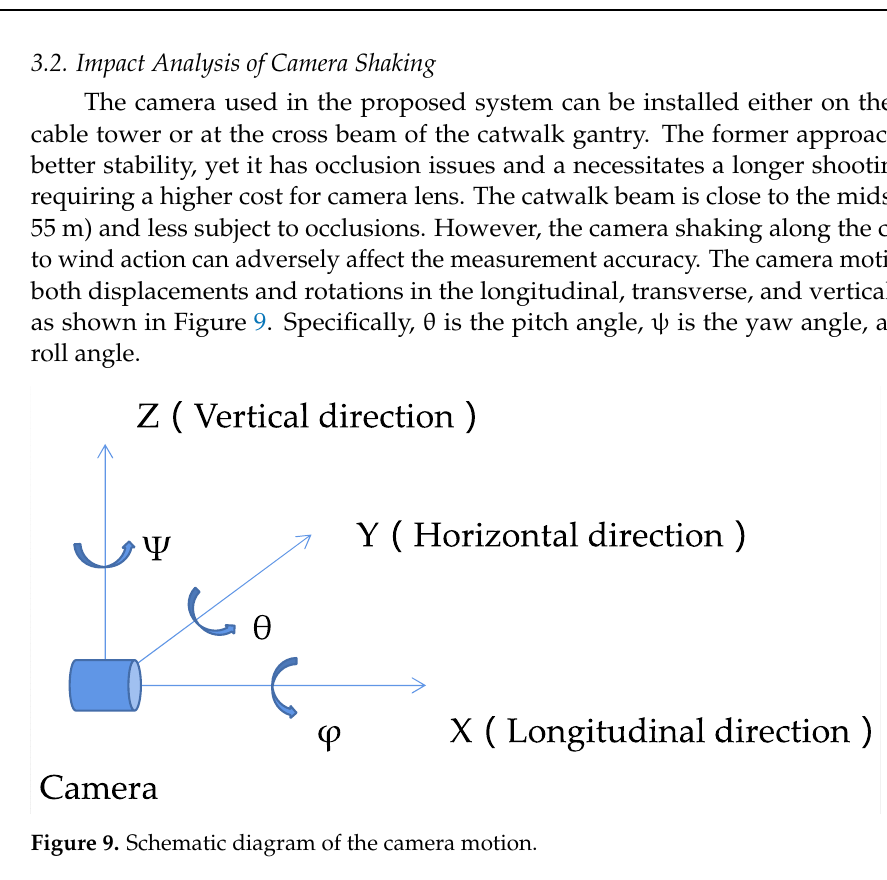
Figure 9. Schematic diagram of the camera motion.